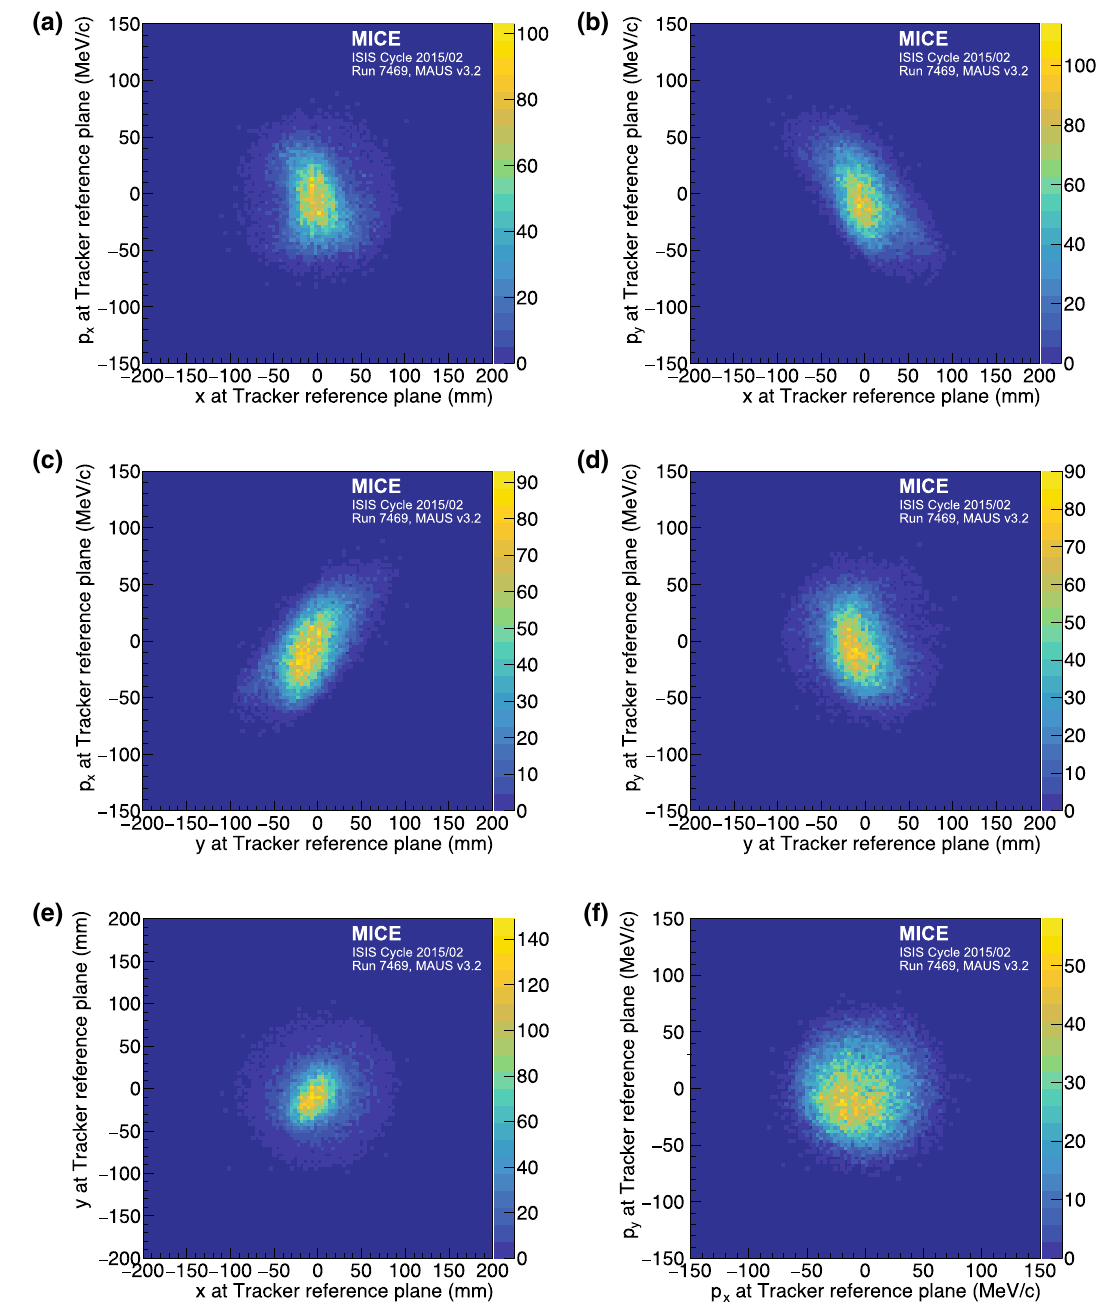
Fig. 6 Transverse phase space occupied by selected muons transported through the MICE Muon Beam line to the reference plane of the upstream tracker. a ( x , p x ) , b ( x , p y ) . c ( y , p x ) , d ( y , p y ) . e ( x , y ) , and f ( p x , p y )